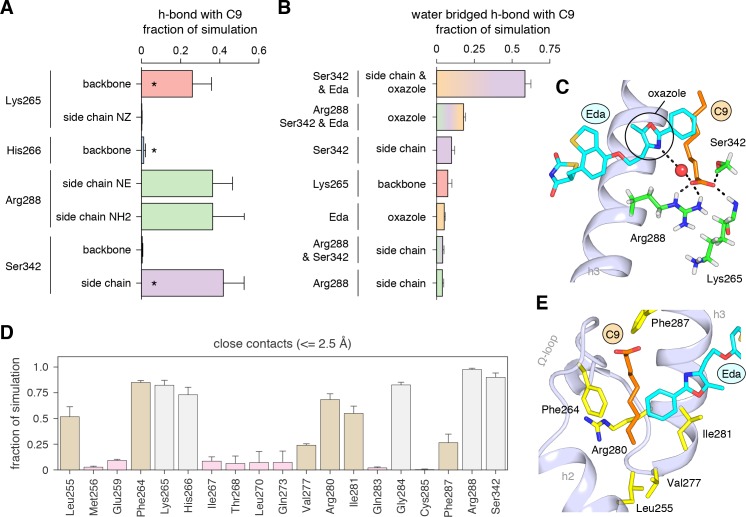
Interactions driving cobinding of C9 to the alternate site.(A) Direct and (B) water-bridged hydrogen bonds detected in the three 2 μs molecular simulations where C9 remained stably bound; * denotes hydrogen bonds observed in crystal structure. Data plotted as the average and S.D. of three experimental replicates. (C) Example of the C9-mediated hydrogen bond network from a snapshot of the simulation trajectory. (D) Close atomic contacts populated in the simulation (brown, hydrophobic side chain contacts; grey, other contacts; pink, lower abundance contacts). Data plotted as the average and S.D. of three experimental replicates. (E) Structural example of the hydrophobic contacts (brown in D).